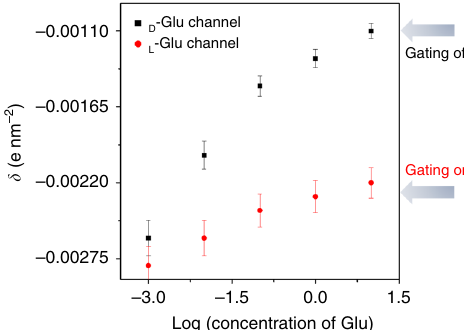
Fig. 6 The relationship of surface charge density vs. Log (concentration of Glu). Standard deviation is ±5% and is used for describing the error bars. Each dataset in two cases is tested fi ve times,